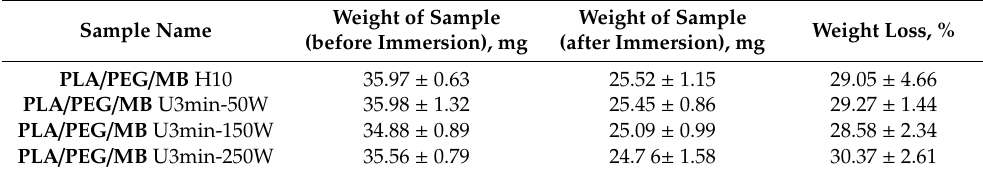
Table 5. Weight loss of PLA / PEG / MB (65 / 35 / 1) tablets after 120 days